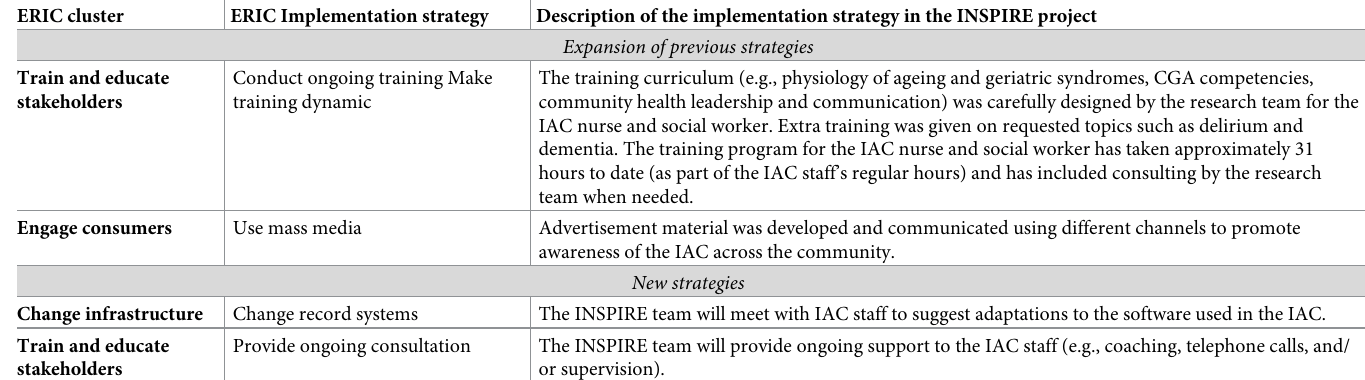
Table 2. Expansion on previous implementation strategies selected for INSPIRE and additional implementation